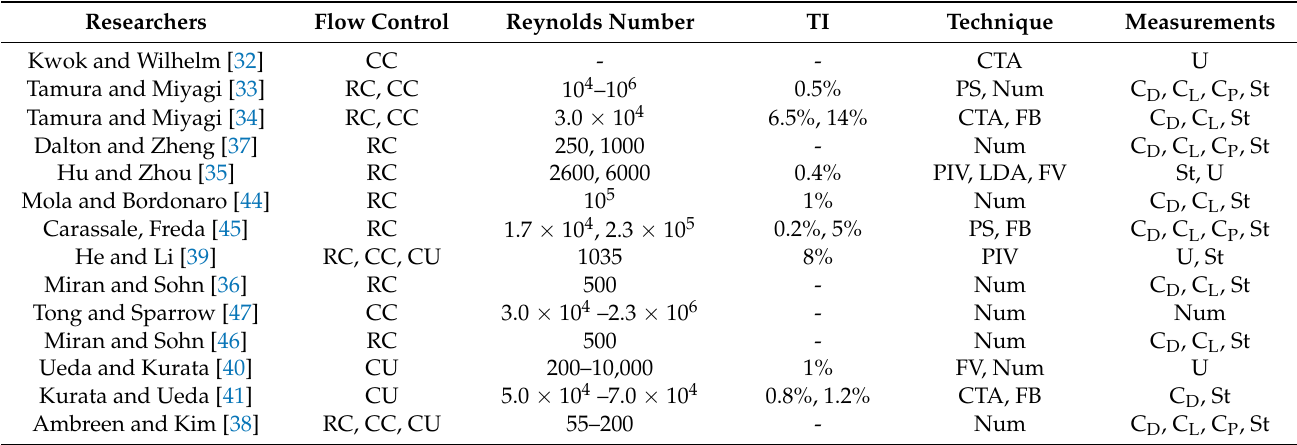
Table 3. Selected studies on flow control and suppression of vortex shedding by employing corner